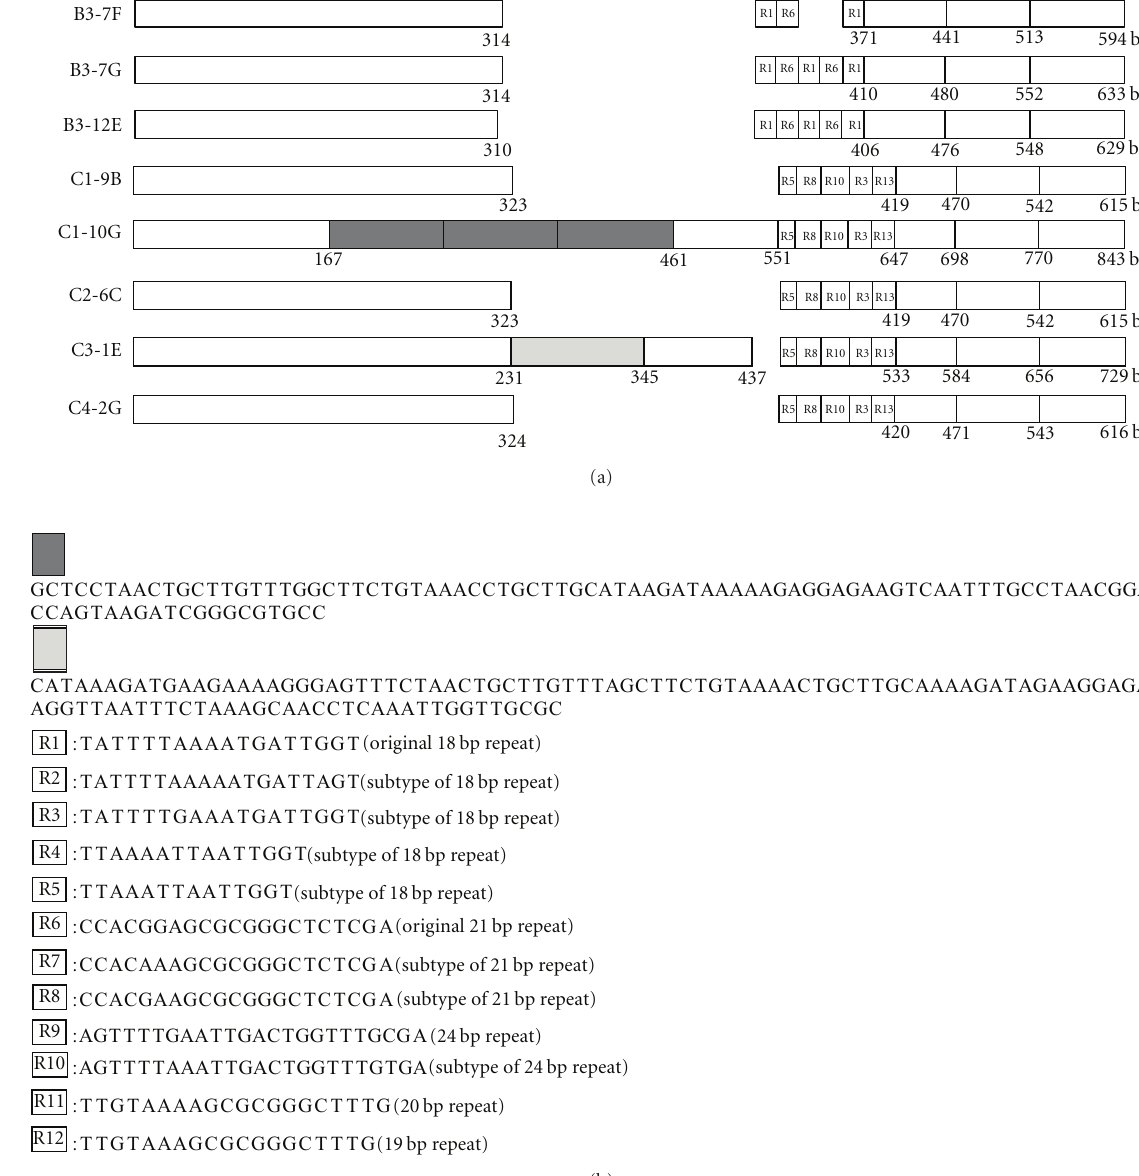
Figure 2: The organization and structure of PERV LTRs identified from the NIH miniature pig BAC clones (a) and the di ff erent subrepeat sequences identified in PERV LTRs